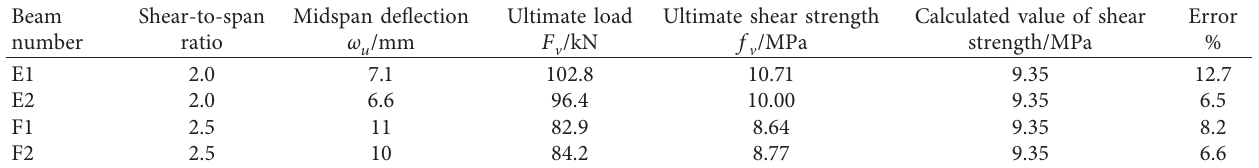
Table 6: The test results of the full-sized members in shear.